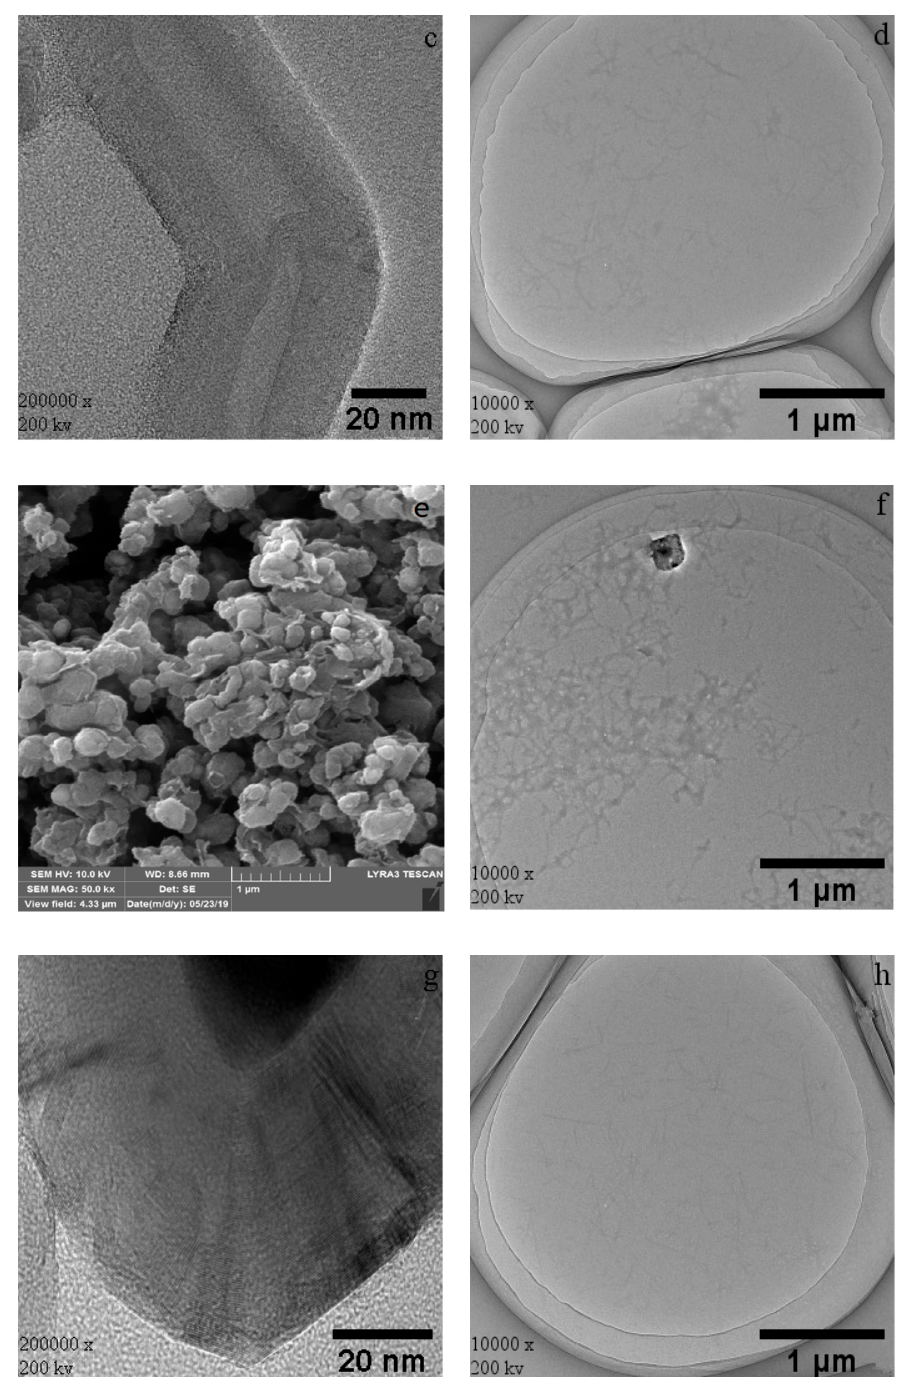
Figure 4. SEM and TEM images of WPI fibril–CNTs (or CNOs): ( a ) SEM image of WPI fibril–CNTs; ( b ) TEM image of WPI fibril–CNTs; ( c ) TEM image of CNTs in WPI fibril–CNTs; ( d ) TEM image of WPI fibrils in WPI fibril–CNTs; ( e ) SEM image of WPI fibril–CNOs; ( f ) TEM image of WPI fibril–CNOs; ( g ) TEM image of CNOs in WPI fibril–CNOs; ( h ) TEM image of WPI fibrils in WPI fibril–CNOs.